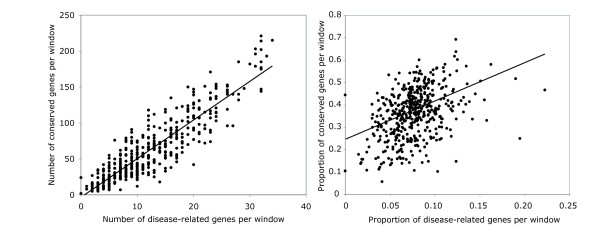
There is a significant correlation between microsynteny and density of disease-gene orthologs over the mouse genome as a whole. Panel A: The number of conserved genes plotted against the number of disease genes for 20 Mb sliding windows of the mouse genome. Note the fit with the regression line (Pearson's R = 0.90, P < 1 × 10-6). Panel B: The relationship between the proportion of genes with conserved microsynteny (number of conserved genes per window/total genes per window) and the proportion of genes with disease orthologs (number of disease-related genes/total genes per window). The correlation for the whole mouse genome is significant (Pearson's R = 0.40, P < 4.0 × 10-4).